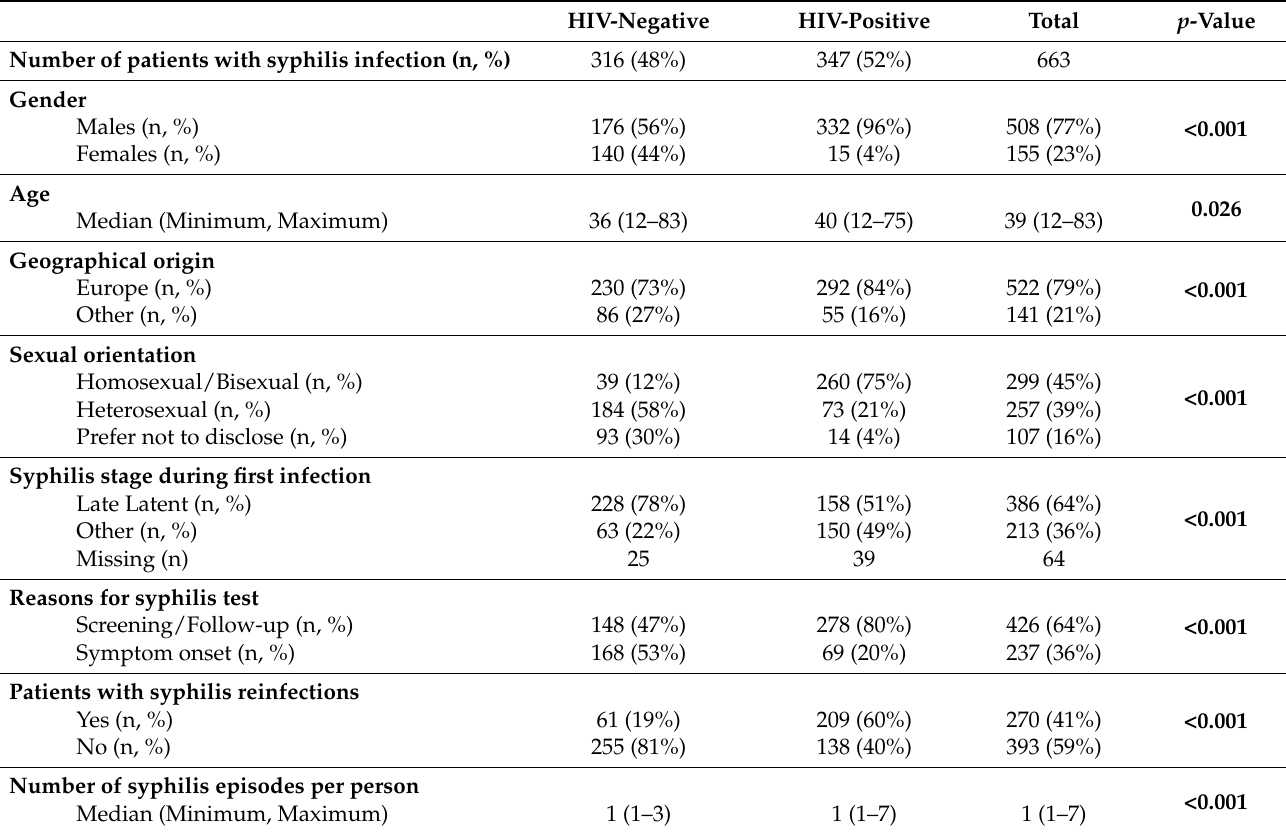
Table 2. Demographic characteristics of the study population.